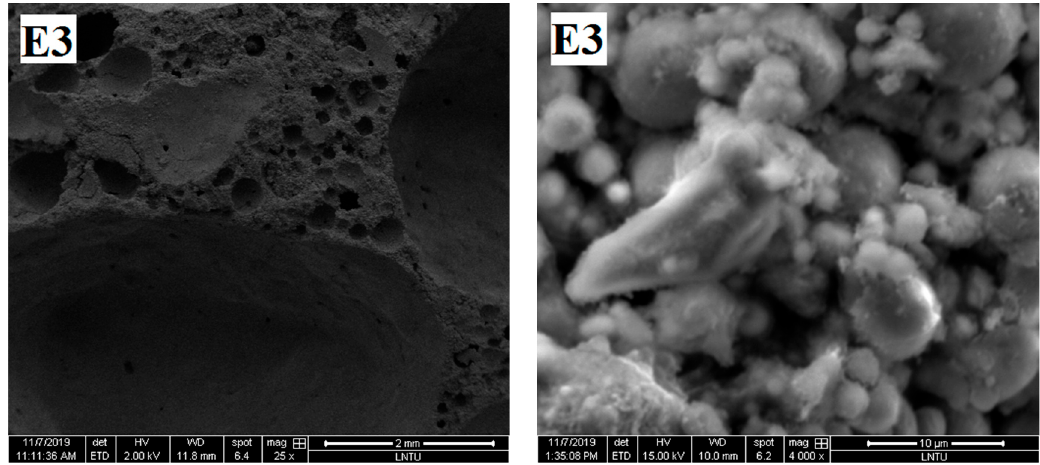
Figure 6. SEM images of samples.